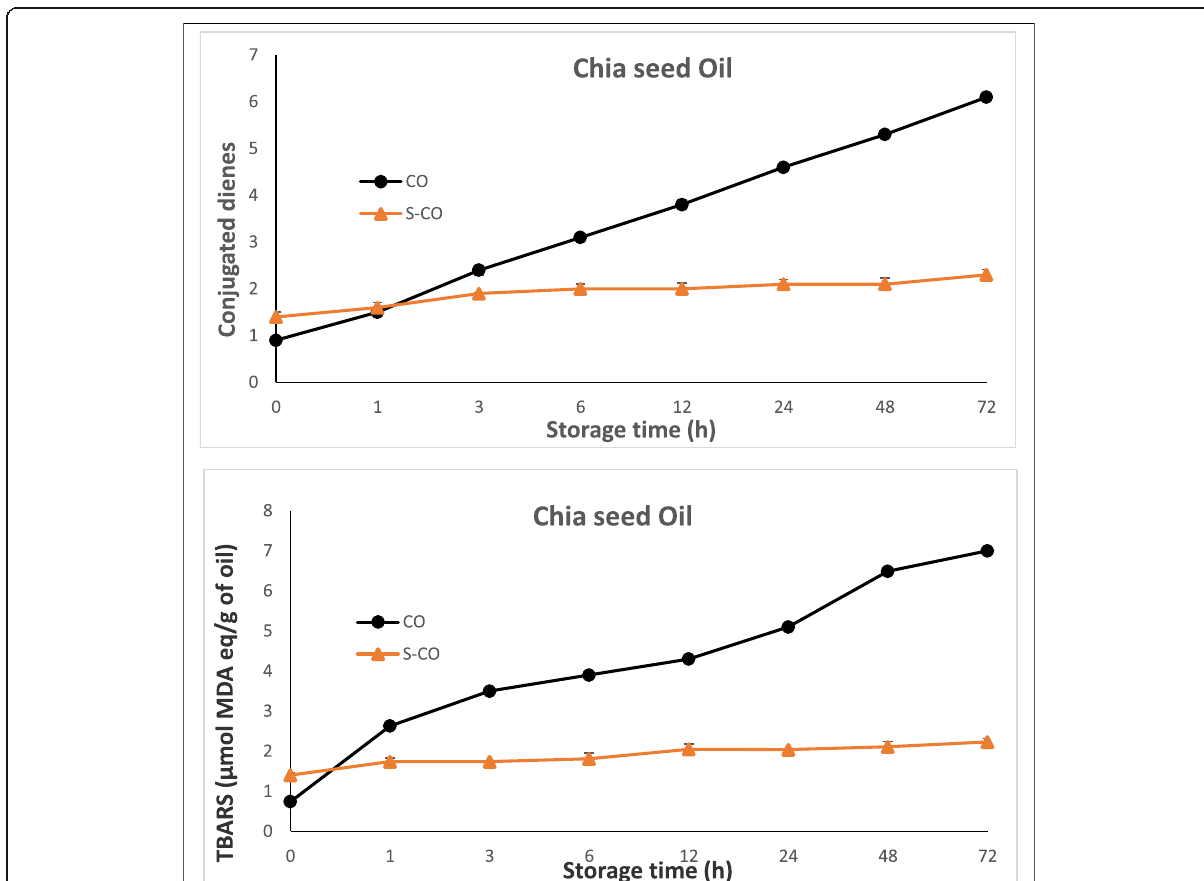
Fig. 3 Conjugated dienes and thiobarbituric acid reactive substances (MDA equivalents) of crude chia oil (CO) and stripped chia oil (S-CO) during 72 h storage period under fluorescent light at 27 °C ( P <